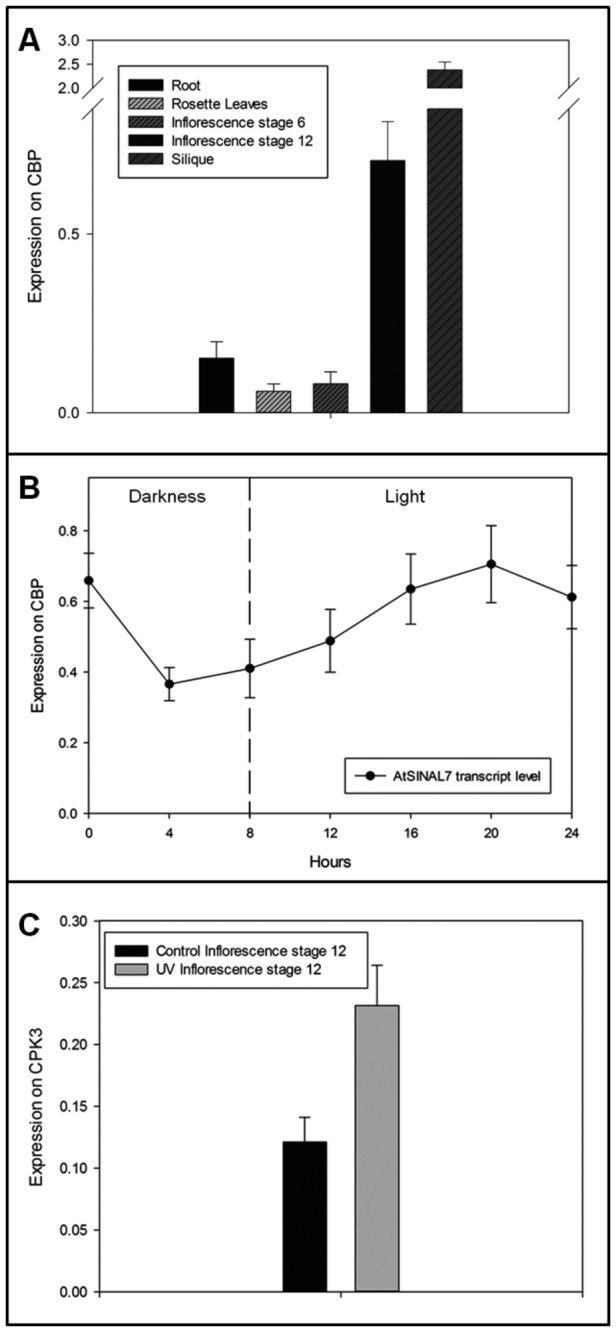
Analysis of AtSINAL7 mRNA levels (A) AtSINAL7 transcript expression profile in different organs from A. thaliana.AtSINAL7 transcript levels relative to CBP control gene expression were determined by RT-qPCR in several A. thaliana organs. Data shown represent at least three independent experiments (significant statistical difference was determined using t test, P <0.05). (B) Time-course expression of AtSINAL7 transcripts. Determination of the transcription levels of AtSINAL7 at 0, 4, 8, 12, 16, 20, and 24 hours under long day growth conditions. Transcripts levels are plotted as relative values using the cap binding protein (At5g44200) mRNA as an internal control. Data shown represent at least three independent experiments (significant statistical difference was determined using t test, P <0.05). (C) Effect of the UV–B treatment on the AtSINAL7 transcript levels in wild type A. thaliana inflorescences. The AtSINAL7 transcript expression in A. thaliana inflorescences (stage 12) relative to cpk3 (calcium-dependent protein kinase 3, At4g23650) was determined after 4 h of UV–B exposure. Control plants were protected from UV–B irradiation using polyester filters (see Methods). Data shown represent at least three independent experiments (significant statistical differences determined using t test, P <0.05).